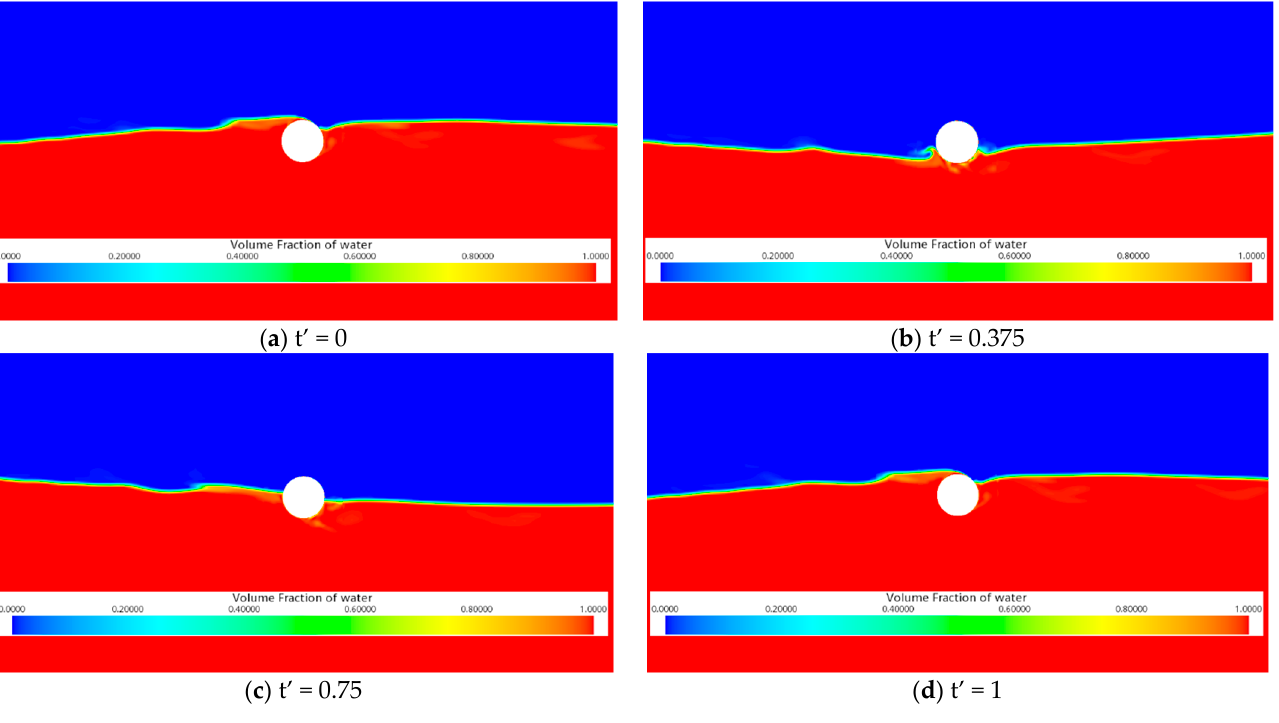
Figure 13. The volume fraction of water over one wave period ( S/D = 0).